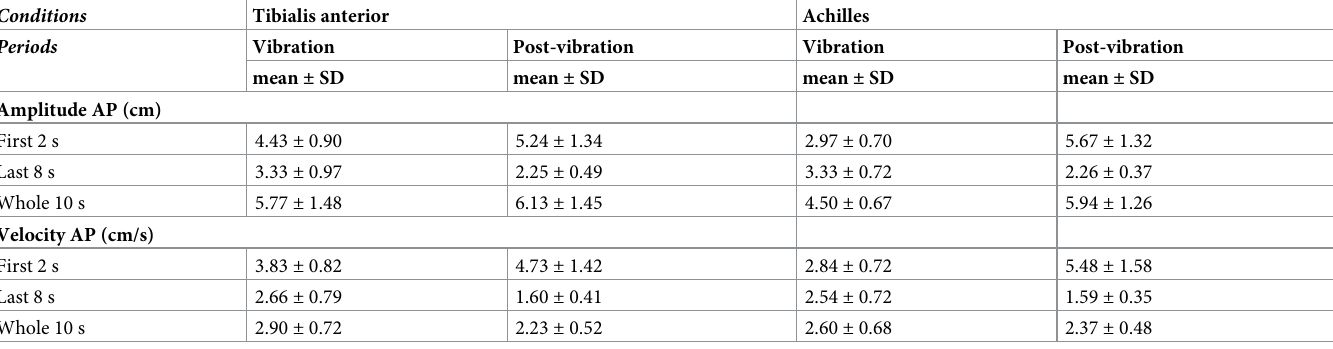
Table 1. Group results for the selected variables, conditions and time-windows analyzed.